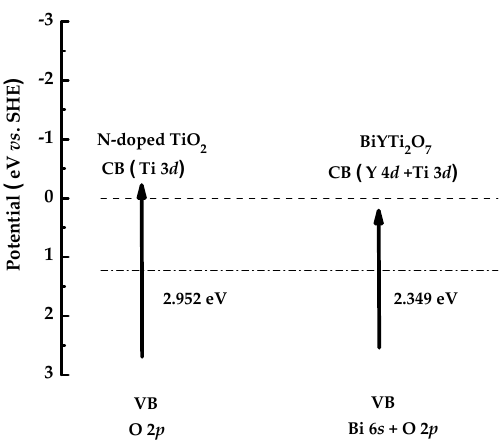
Figure 9. Suggested band structures of BiYTi 2 O 7 .